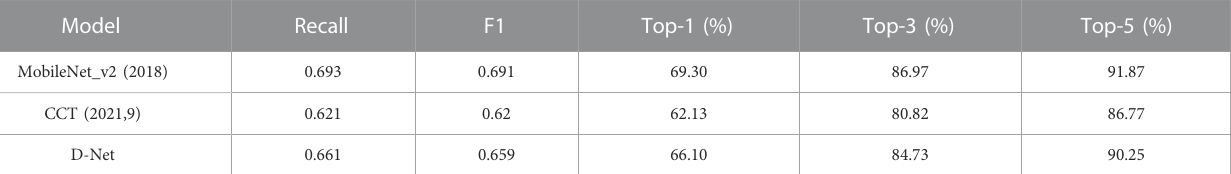
TABLE 6 Data comparison of D-Net on cifar_100.